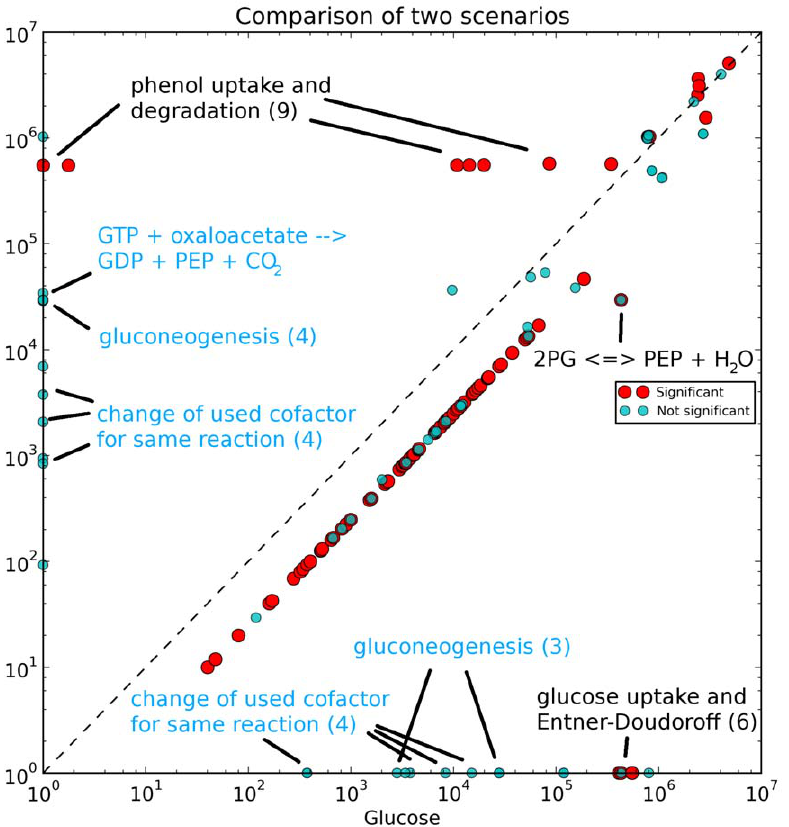
Figure 7. Scatter plot of the flux distributions during growth on glucose and the phenol-utilizing scenario. Red dots show significant differences and blue dots show not significant differences between both scenarios. Blue labels describe not significant differences. The numbers indicate the number of involved reactions.